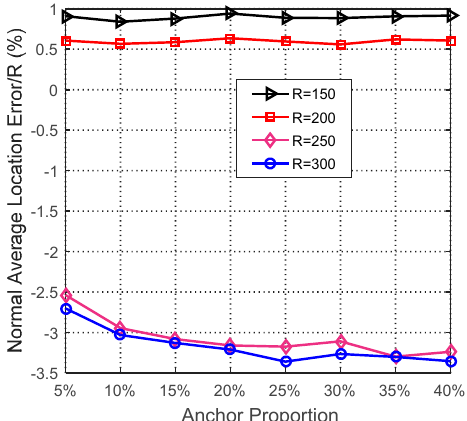
Figure 17. The influence of R for WSN#1.